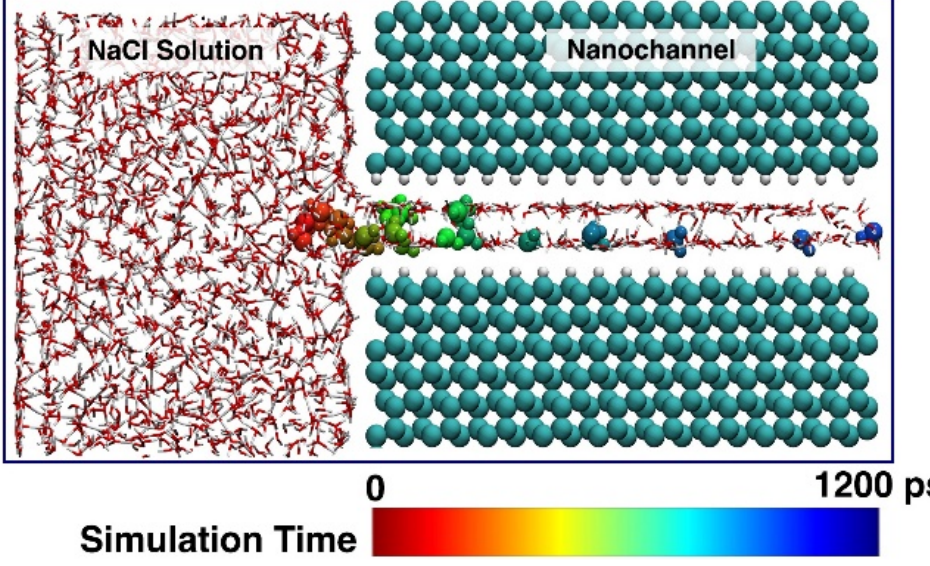
Figure 3. Location trajectory of a selected water molecule in the diamond nanochannel. The location of the water molecule is colored according to the simulation time.